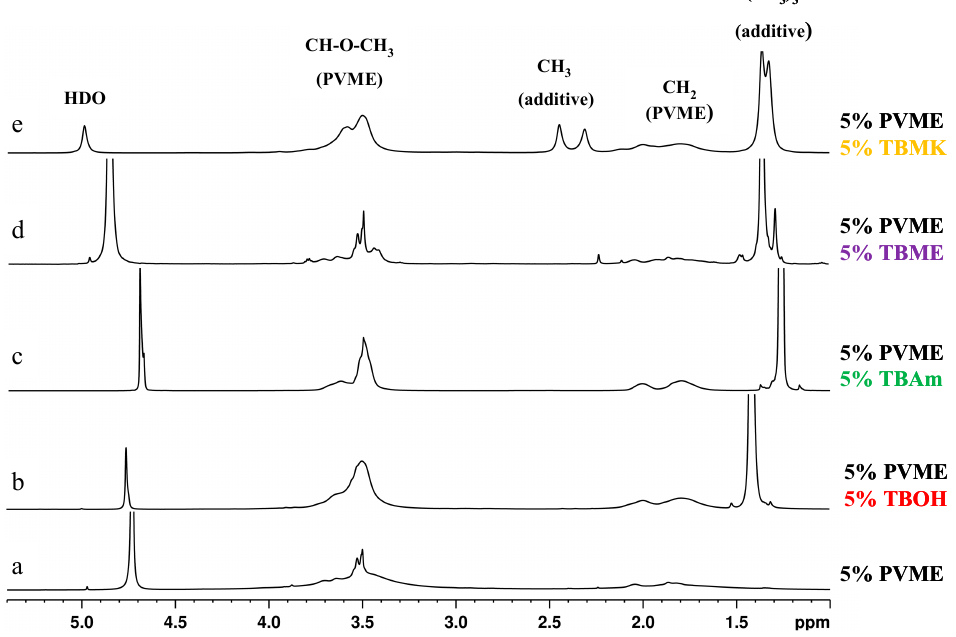
Figure 2. High-resolution 1 H NMR spectra of D 2 O solutions of neat PVME ( c P = 5 wt %) ( a ); and solutions with additives TBOH ( b ); TBAm ( c ); TBME ( d ); and TBMK ( e ) ( c P = 5 wt %, c ad = 5 wt %) measured at temperatures above the transition of each particular system.